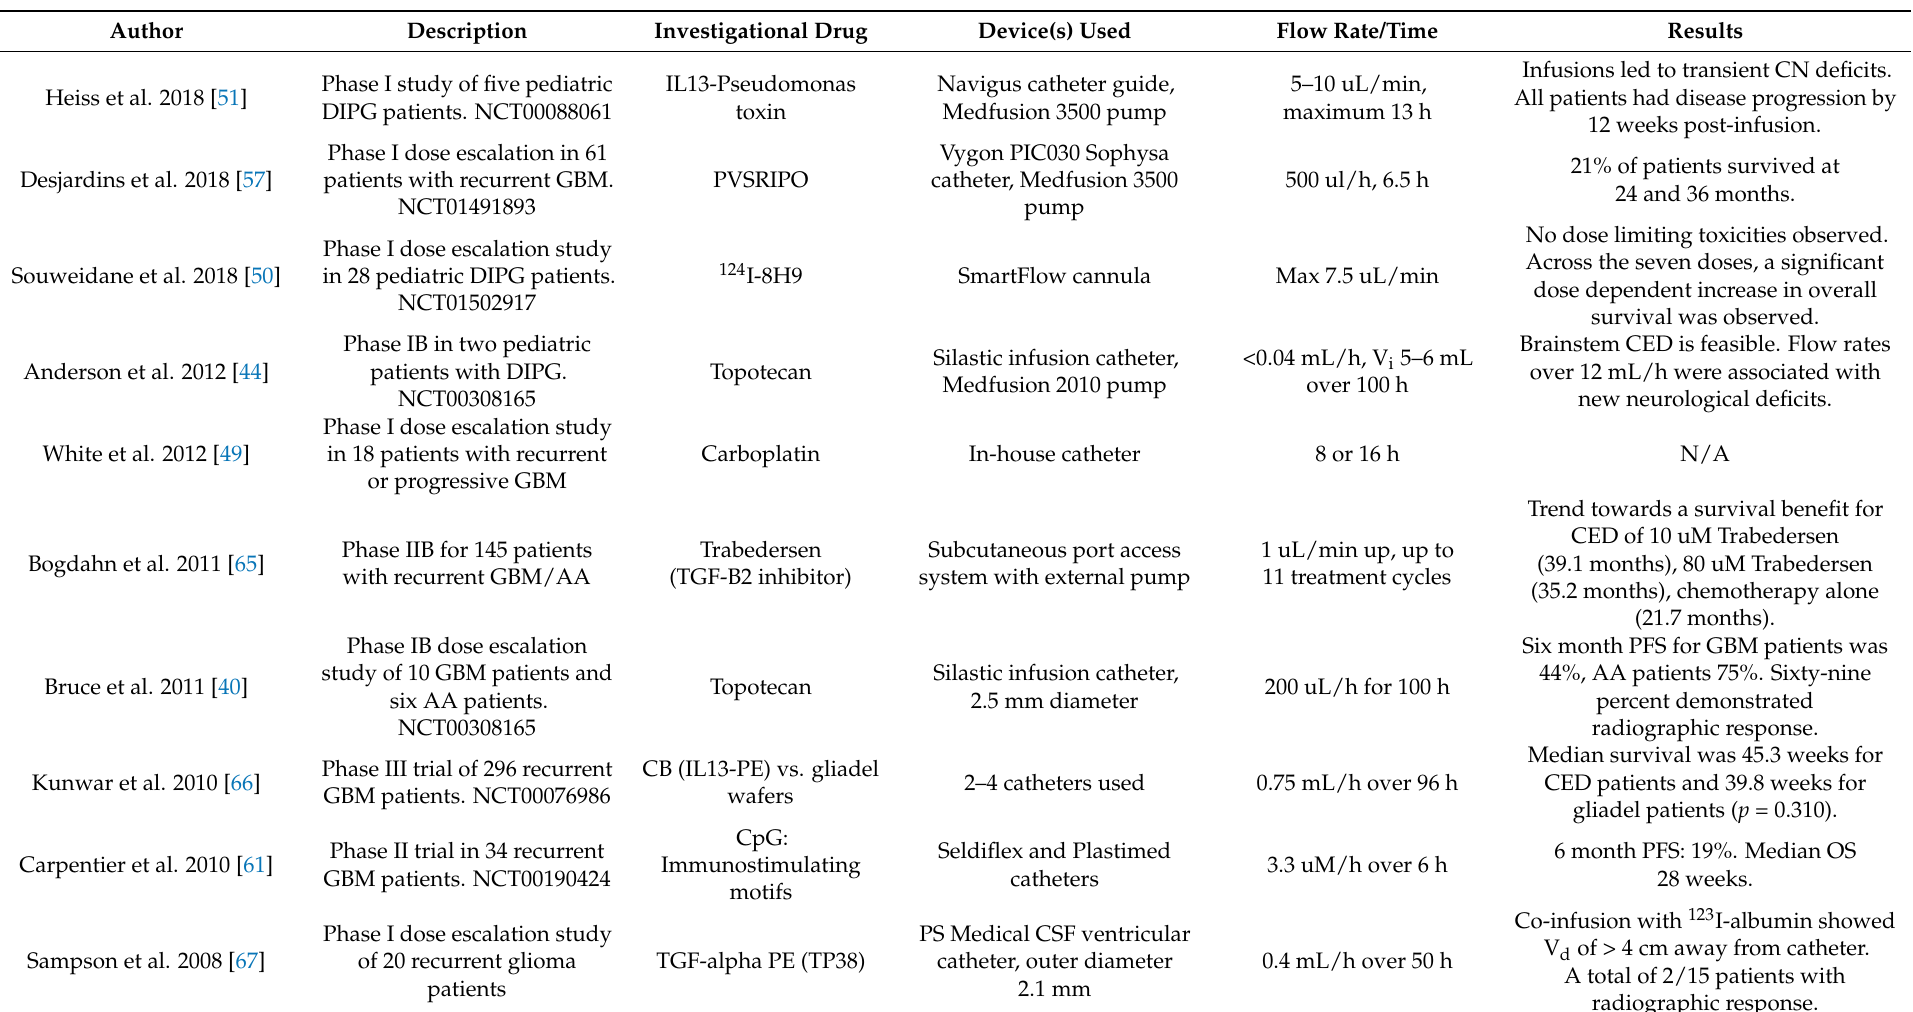
Table 1. Summary of clinical